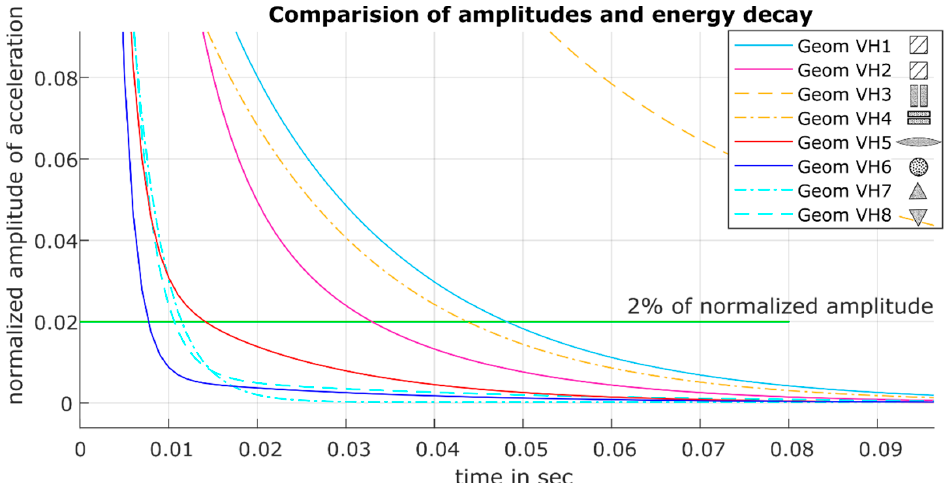
Figure 11. Acceleration amplitudes over time.